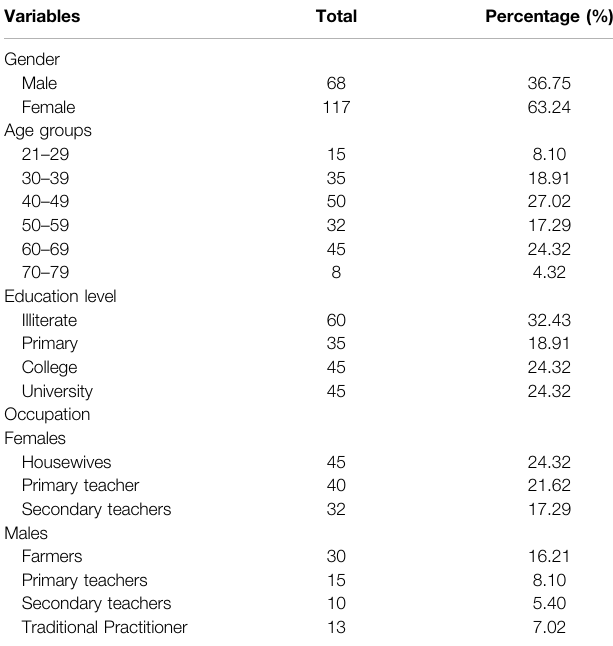
TABLE 1 | Socio-demographic characteristics of the respondents ( n (cid:1) 185) in ethnobiological data collection.